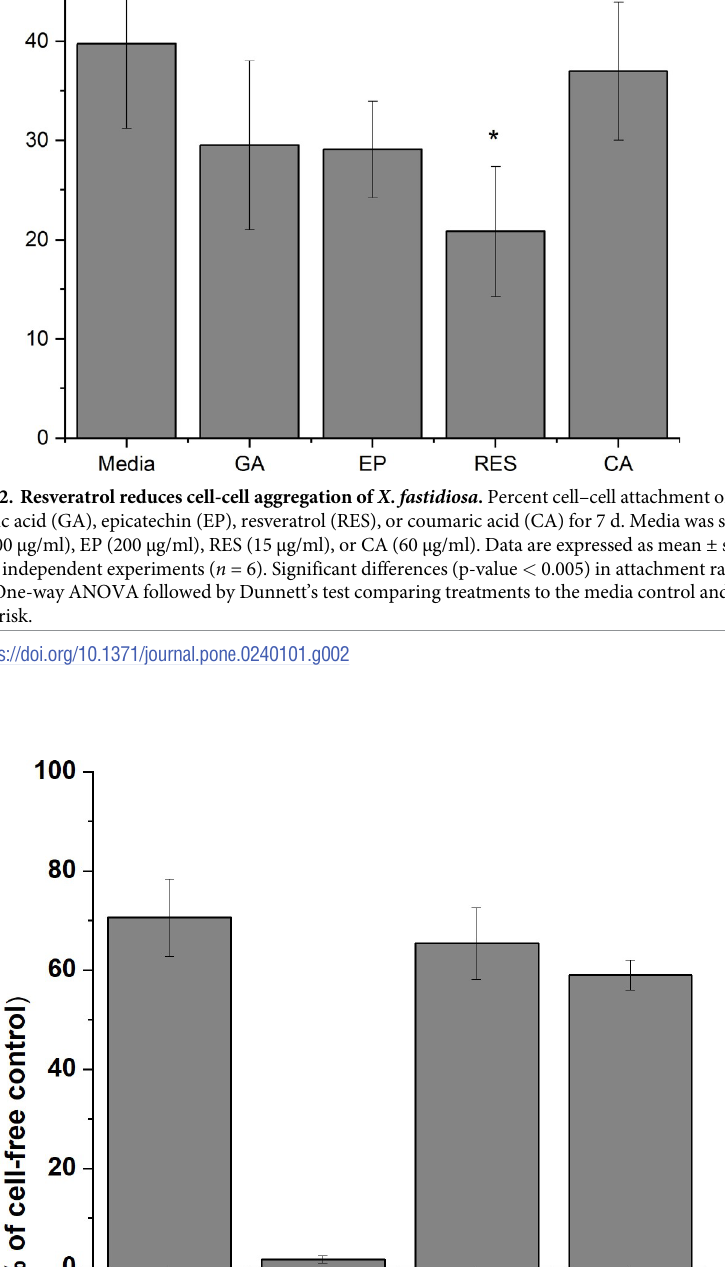
PLOS ONE | https://doi.org/10.1371/journal.pone.0240101 October 2,